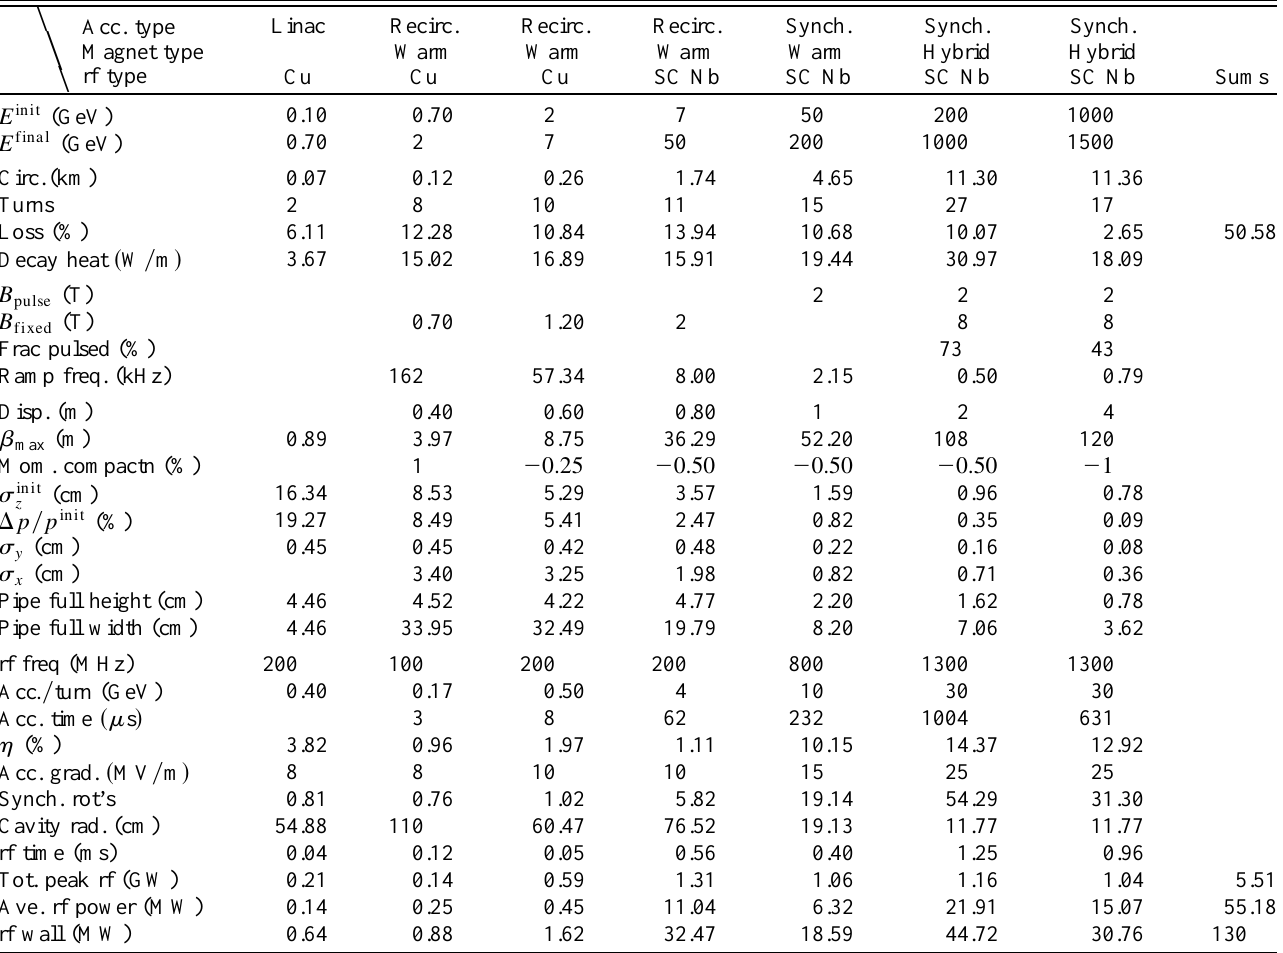
TABLE X. Parameters of acceleration for a 3 TeV